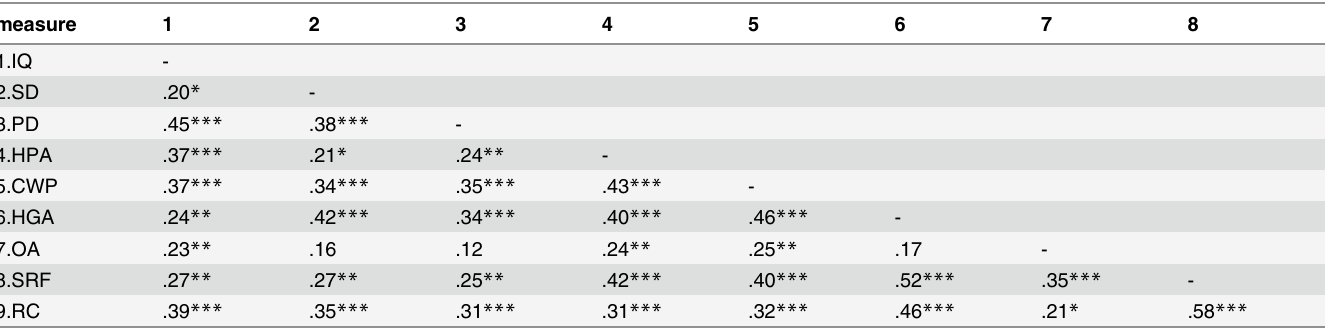
Table 2. Correlations for Observed Variables for Grade 2.